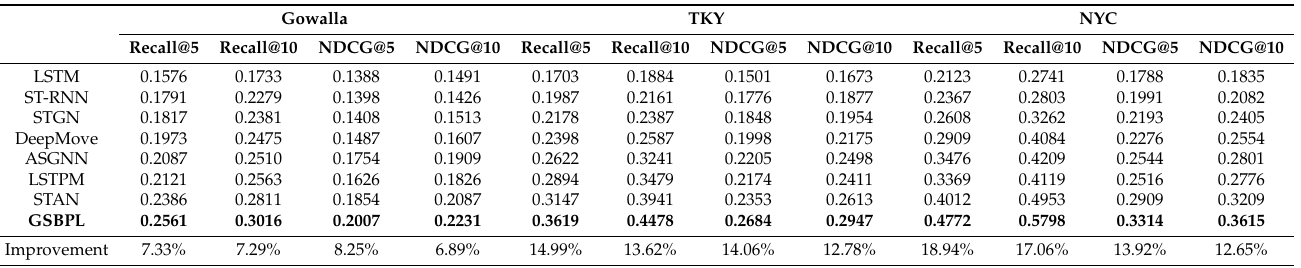
Table 2. Recommended performance comparison with